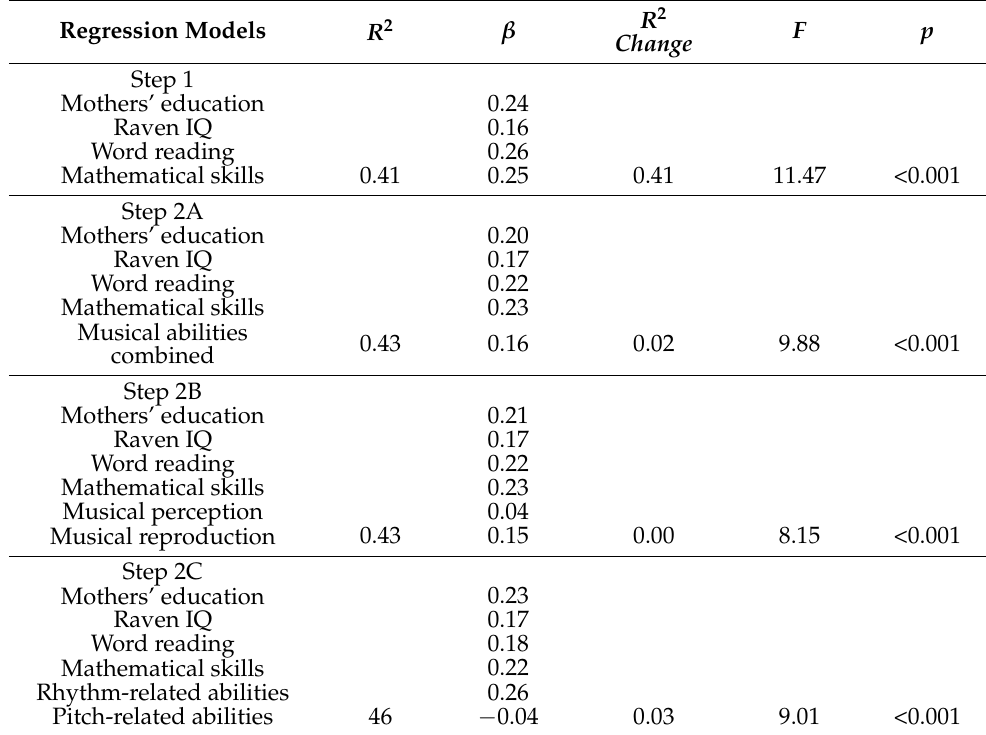
Table 4. Hierarchical regression models with GPA as the dependent